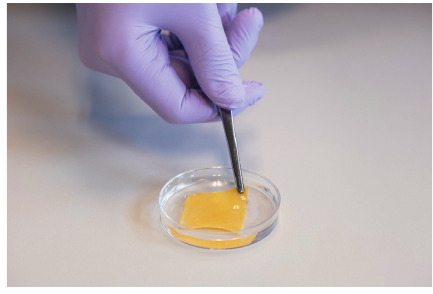
Figure 1: Image of the hydrated